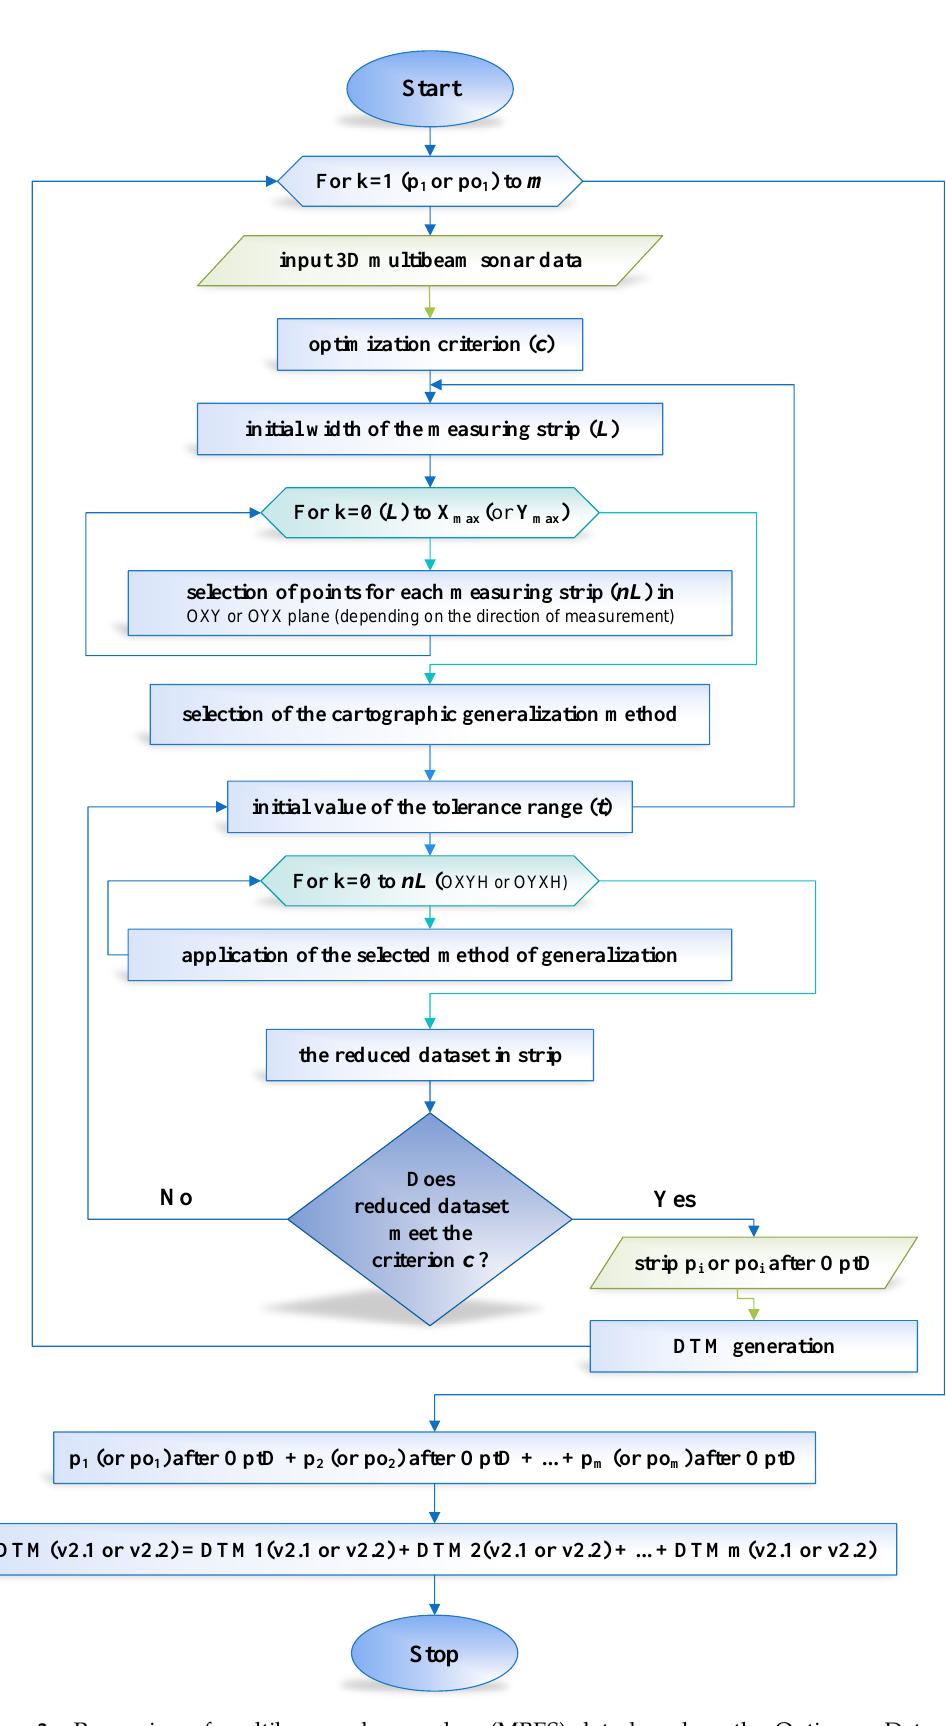
Figure 3. Processing of multibeam echosounders (MBES) data based on the Optimum Dataset OptD method.